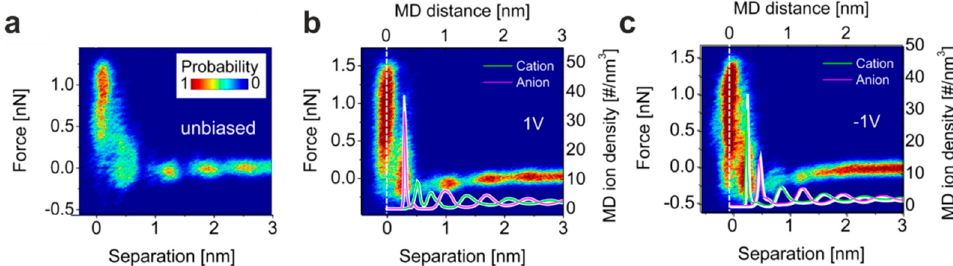
Figure 13. Atomic force spectroscopy (AFS) measurement of the [EMIm][TFSI] / HOPG interface ( a ) with unbiased surface, ( b ) at + 1V, and ( c ) at − 1V sample polarization; ( b , c ) additionally show the ion density of anions and cations derived by molecular dynamics at the interface, depending on the potential. Adapted with permission from Black et al. [101]. Copyright 2013, the American Chemical Society.